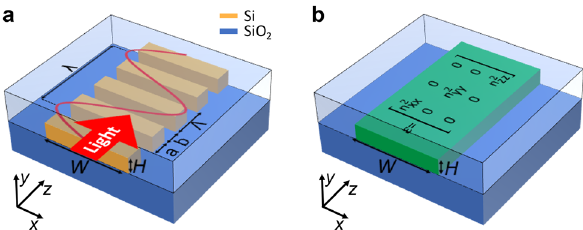
Figure 2: (a) Schematic of a longitudinal SWG waveguide. The period of the structure, Λ , is much shorter than the guided wavelength, λ , of the light propagating along the z -axis. (b) Schematic of the homogeneous waveguide model of the structure shown in (a). The SWG waveguide core is modeled as a homogeneous anisotropic medium with a permittivity tensor